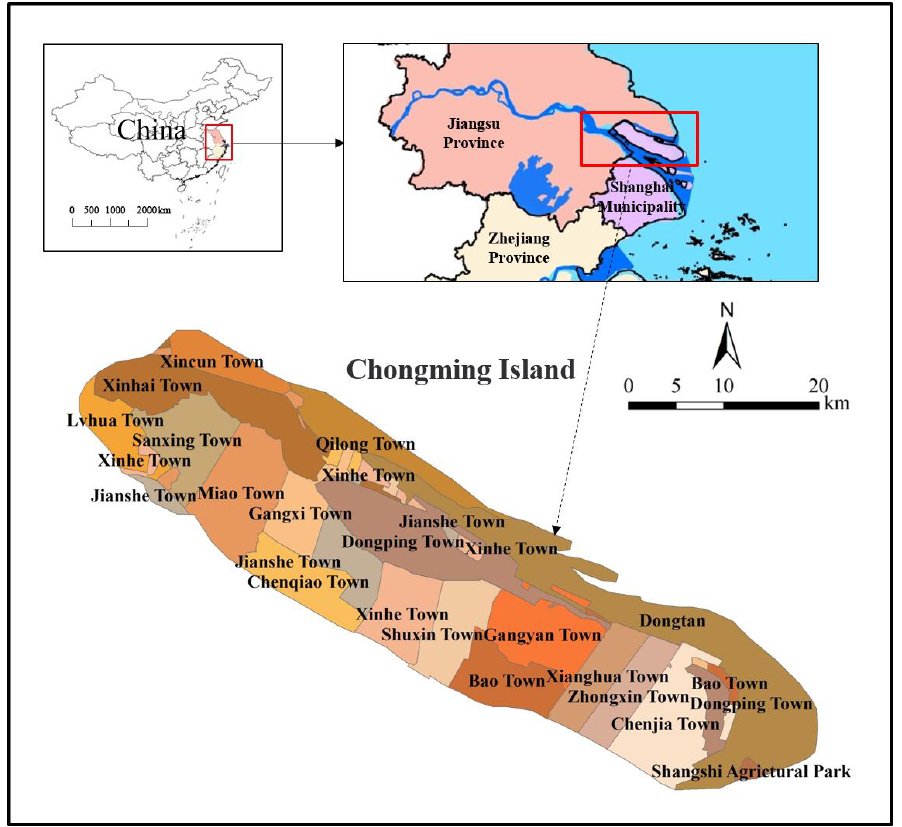
Figure 1. Location of the study area.